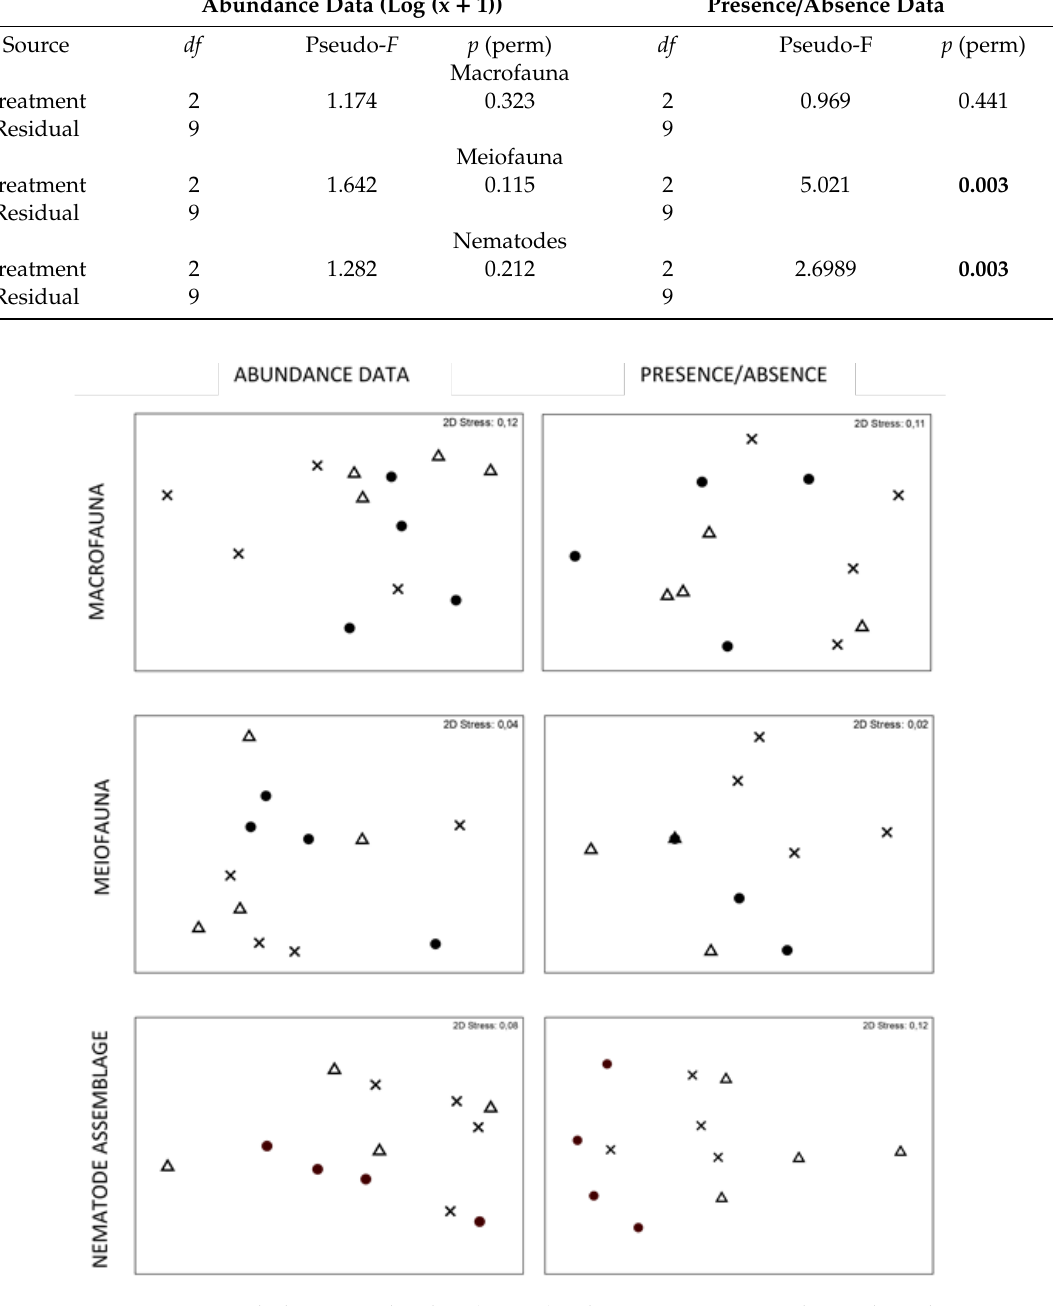
Figure 2. Non-metric multidimentional scaling (NMDS) ordination representing the similarity between samples from the substrates “Turf” (Δ), “Caulerpa” (●) and “Sponge” (x) for macrofauna, meiofauna and nematode assemblages. Table 1. Differences in univariate indices from macro- and meiofauna between substrates (H1) using one-way ANOVA.